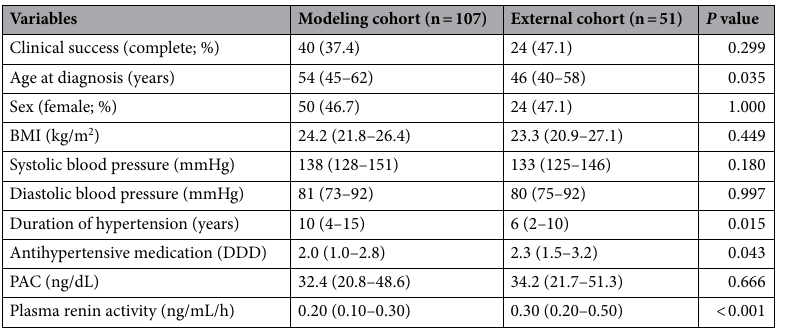
Table 2. Patient clinical characteristics of the modeling and external primary aldosteronism cohort. Data are expressed as medians with interquartile ranges or number with percentage. BMI, body mass index; DDD, defined daily dose; PAC, plasma aldosterone concentration.